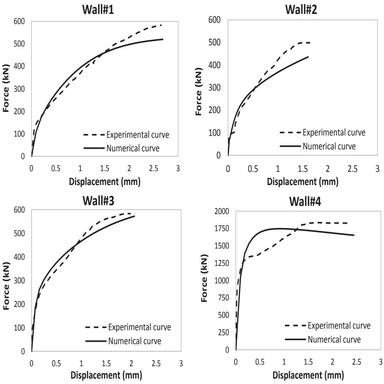
Comparison between experimental and numerical force–displacement (kN - mm) curves after the calibration of the micro-modelling approach.